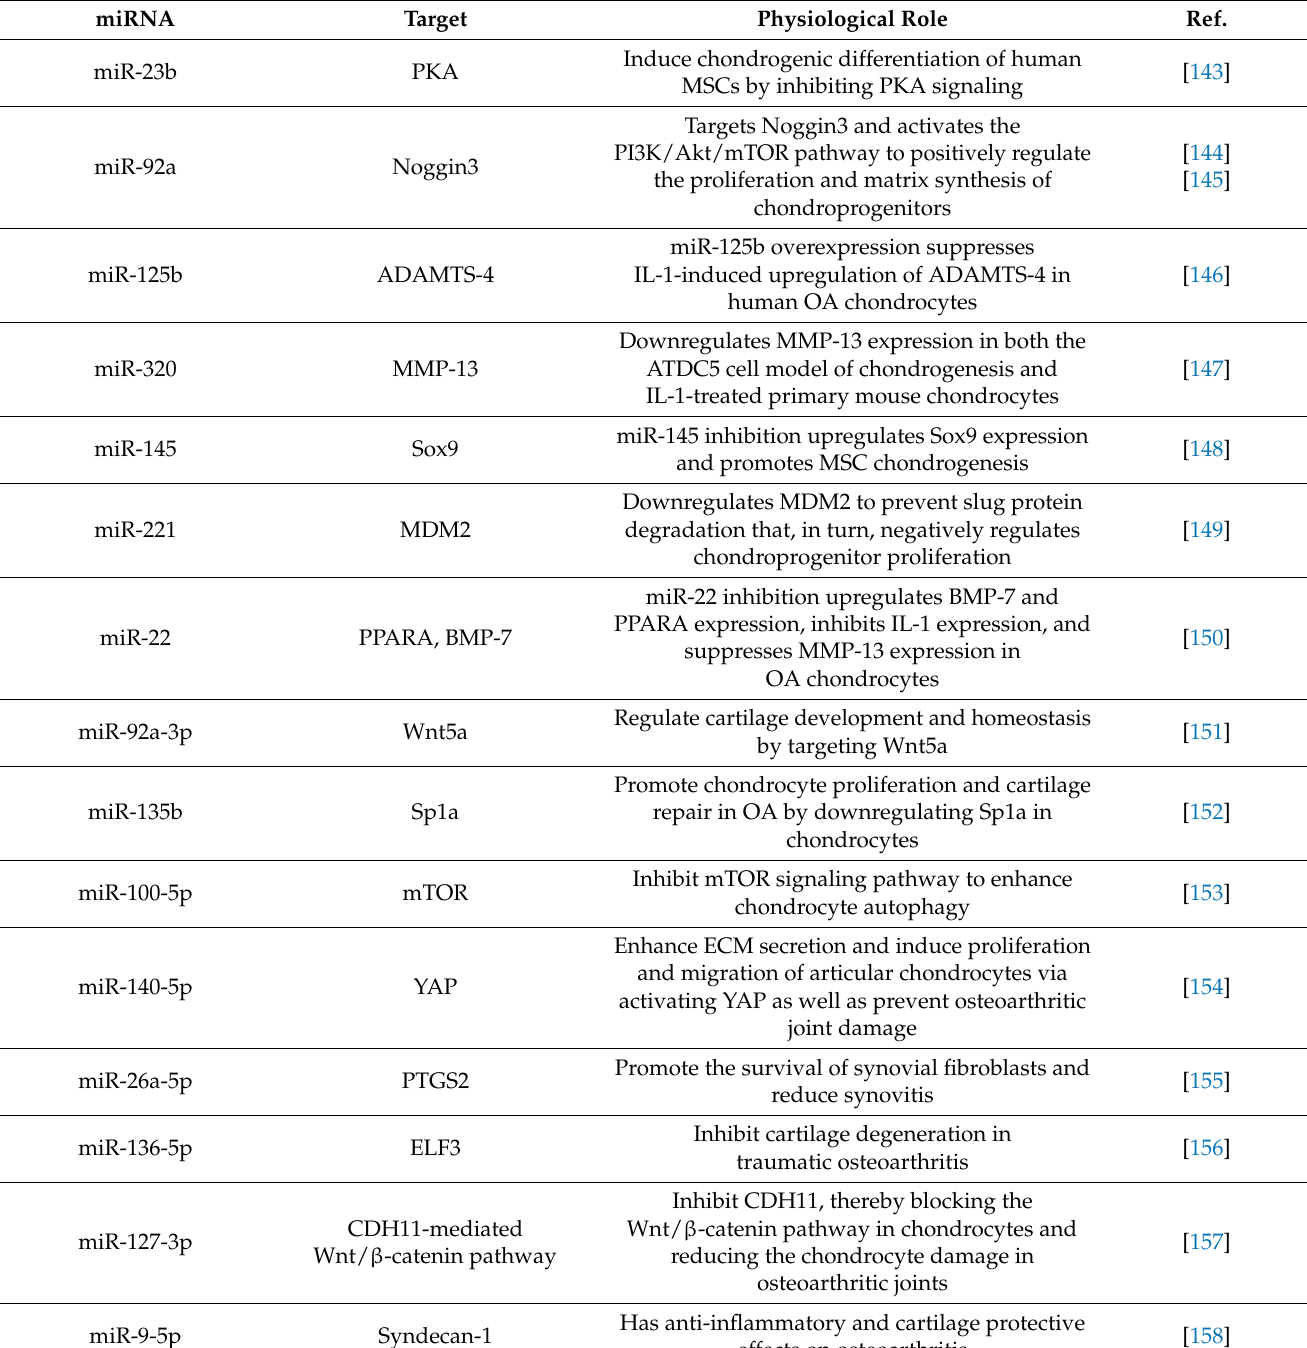
Table 1. List of miRNAs in MSC-derived exosomes related to chondrocytes and cartilage regeneration. miRNA Target Physiological Role Ref. PKA MSCs by inhibiting PKA